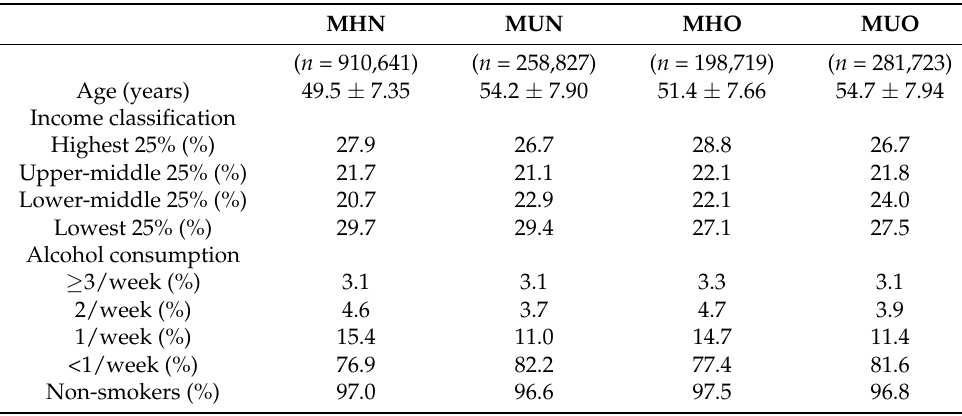
Table 2. Characteristics of the study population at baseline